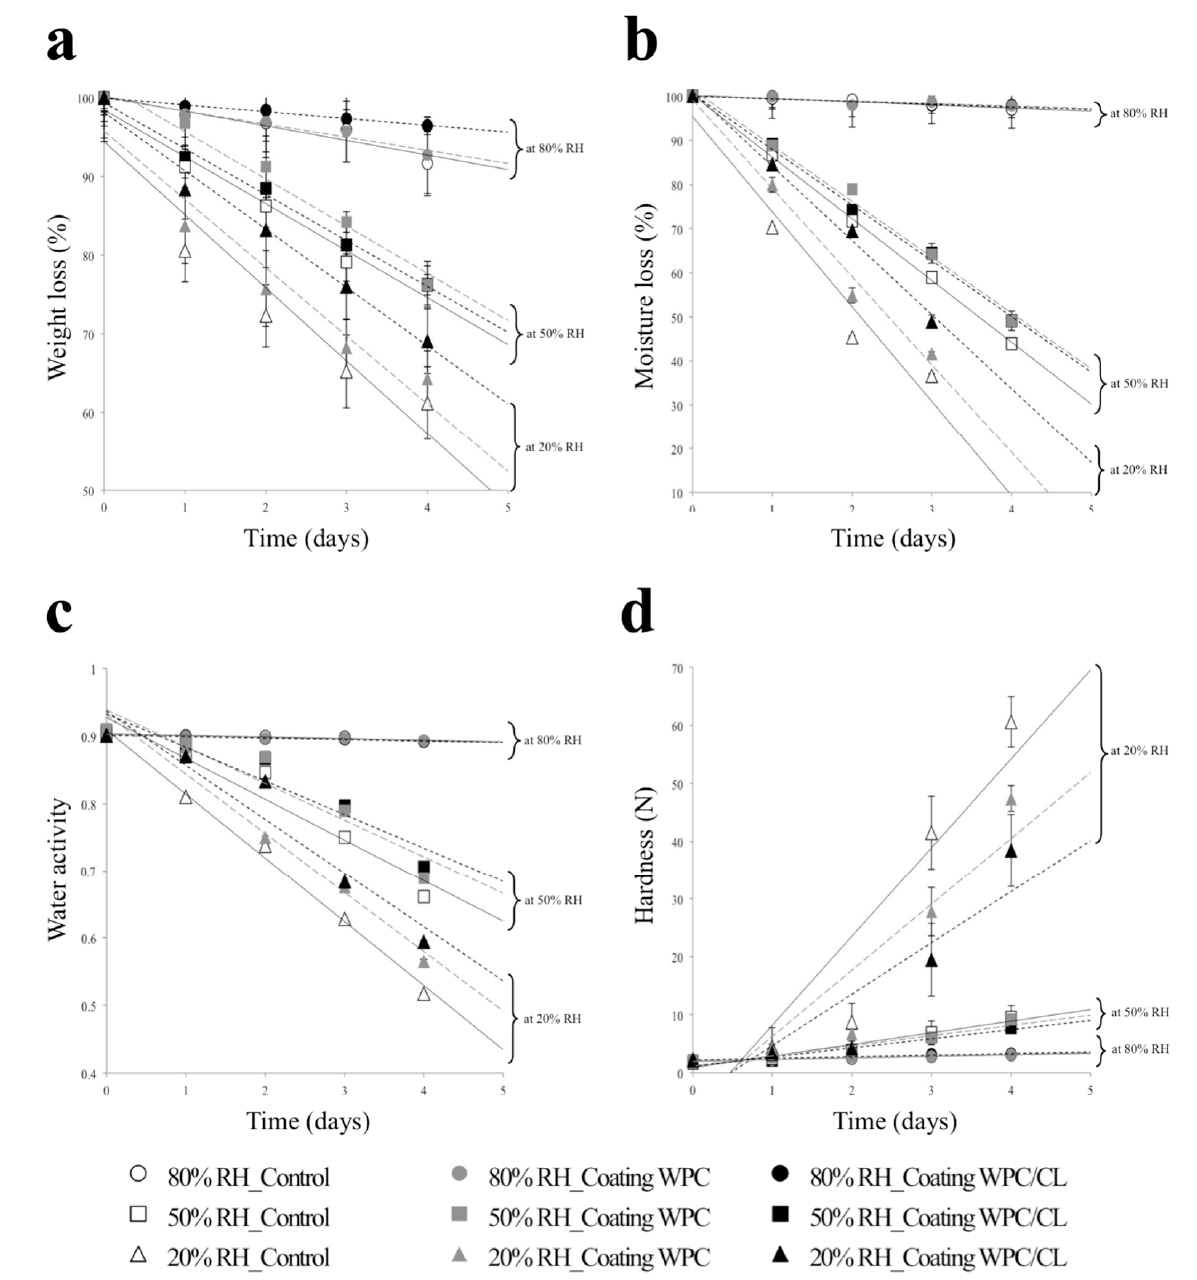
Figure 5. Effect of the coatings on the stability parameters of the muffins stored at 20 °C and different conditions of relative humidity (20, 50, and 80%): ( a ) weight; ( b ) moisture content; ( c ) water activity; and ( d ) hardness.